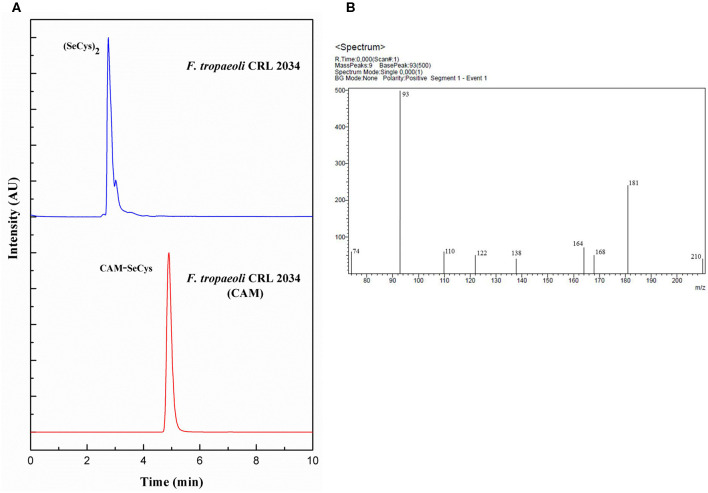
Detection of CAM-SeCys in the cell pellet of F. tropaeoli CRL 2034: (A) Chromatograms obtained from reversed-phase column coupled to ICP-MS, F. tropaeoli CRL 2034 with and without applying the carbamidomethylation procedure are represented in red and blue, respectively; (B) Fragmentation of CAM-SeCys by LC-ESI-MS/MS. AU, arbitrary units; CAM, carbamidomethylated.